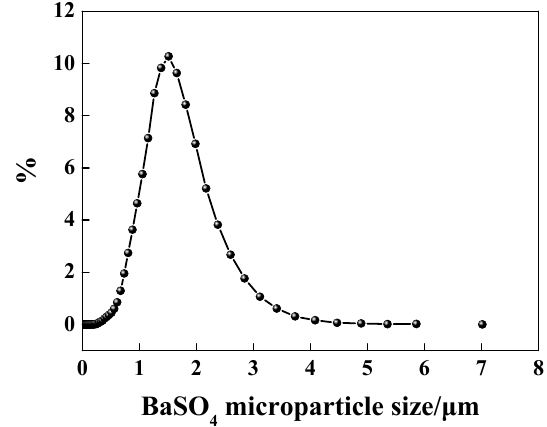
Figure 1. Particle size distribution of BaSO 4 micro-particle.